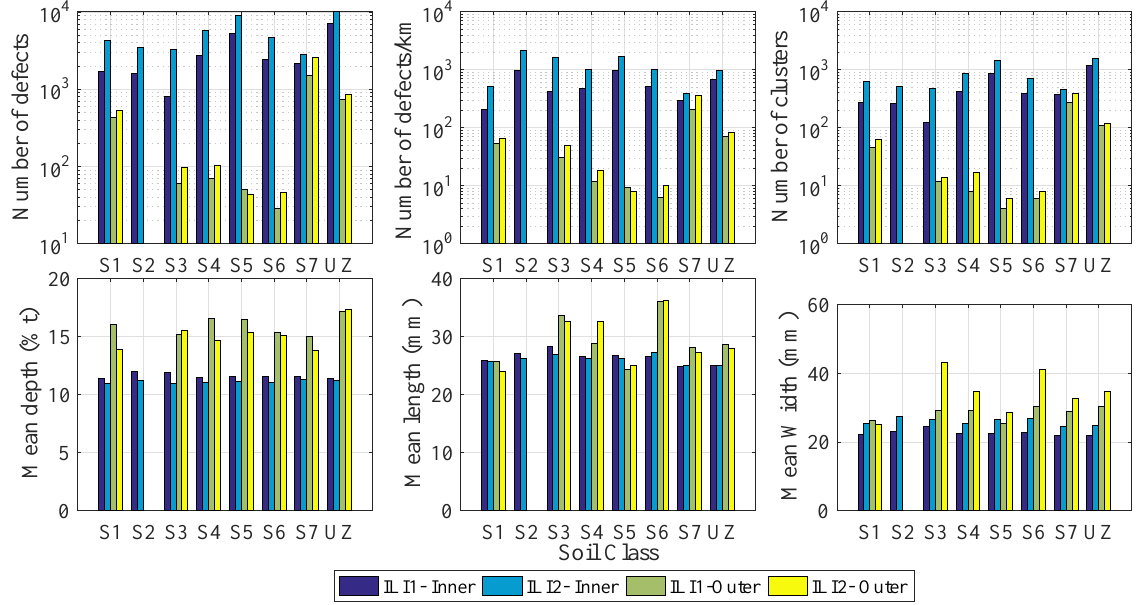
Figure 6. General statistics based on the soil